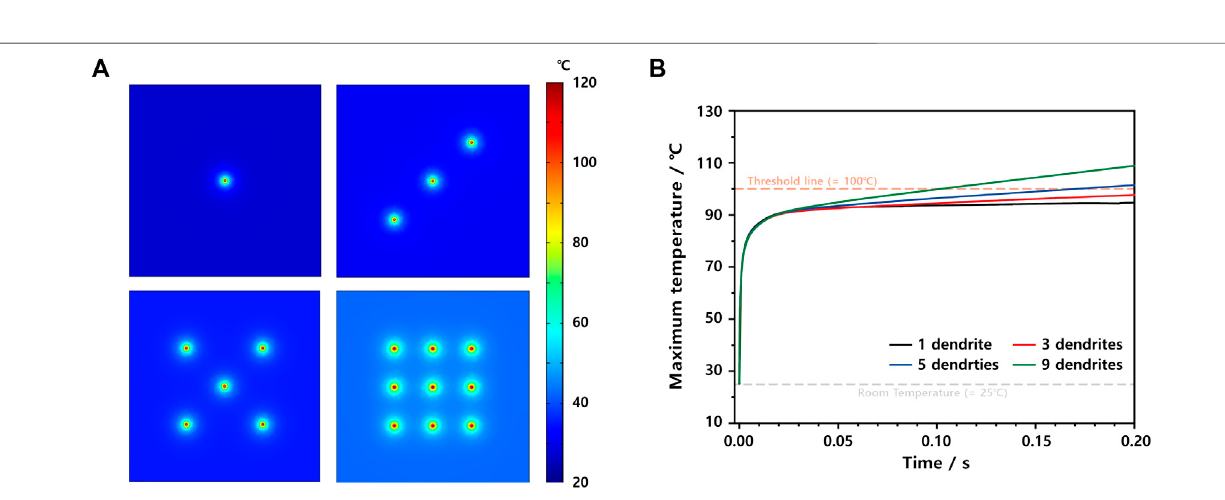
FIGURE 6 | (A) Thermal 2D color map at 0.2 s of ISC models having one Li dendrite, three Li dendrites, fi ve Li dendrites, and nine Li dendrites. (B) Maximum temperature pro fi les of ISC models depending on the number of Li